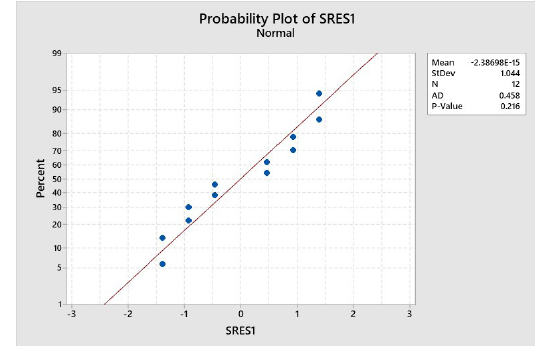
Figure 2. Normal probability plot of the residuals for the transformed tensile strength.